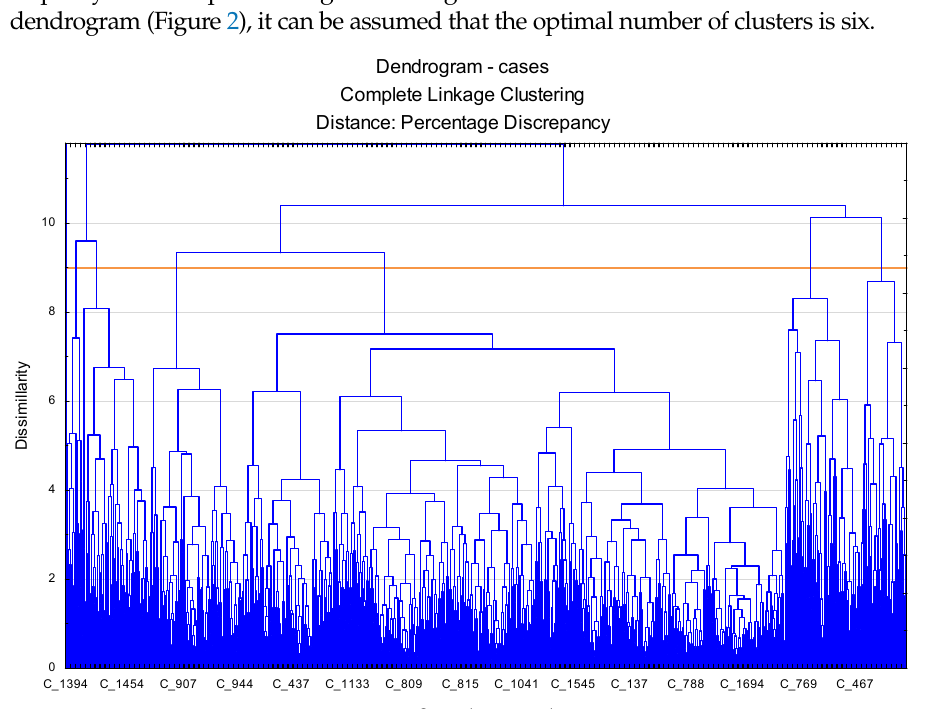
Figure 2. Dendrogram of consumers agglomeration. Individual respondents (observations) were assigned to clusters using the k-variable method. This yielded six clusters of respondents with similar attitudes toward tea pur- chase and consumption. Descriptive statistics, in particular, median—Me and interquar- tile deviation—IQR (Table 5), were used to evaluate the characteristics of respondents in each cluster. Table 5. Values of medians (Me) and quartile ranges (IQR) in the separated groups of respond- ents. Cluster